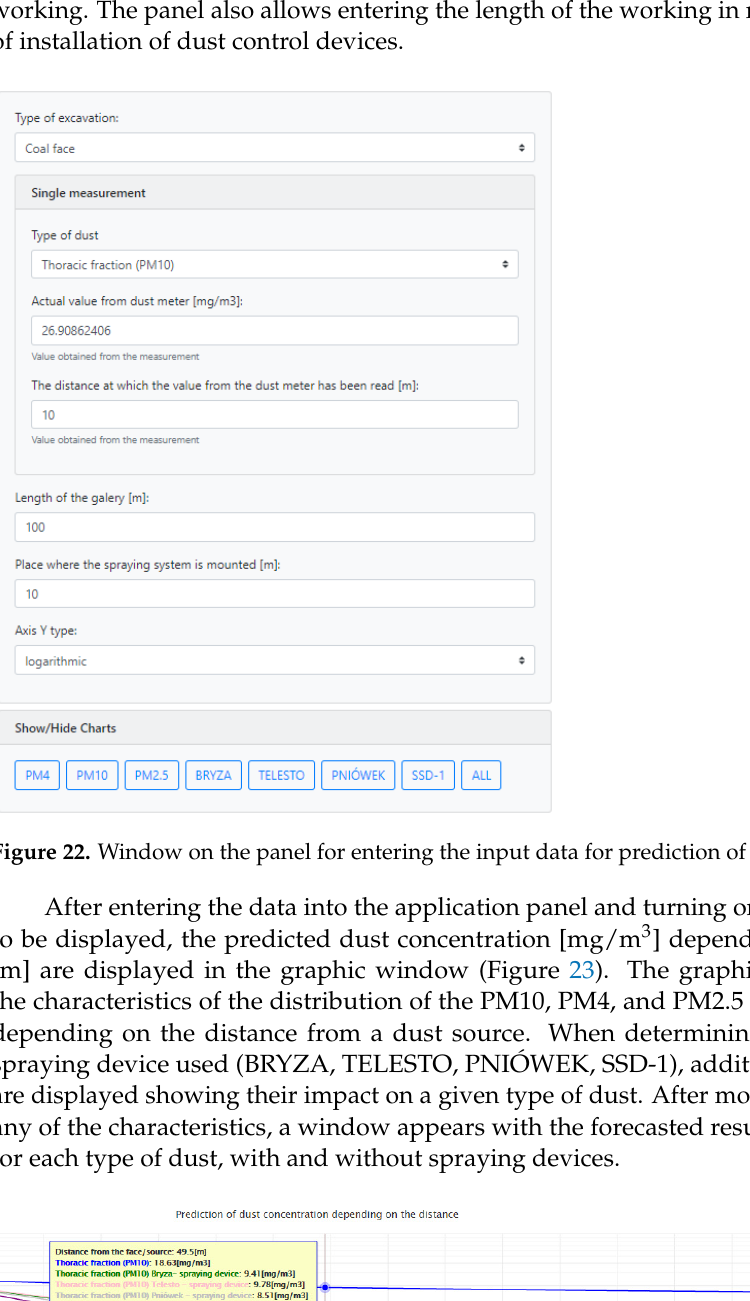
Figure 21. View of the dust prediction application, showing a graph of dust concentration depending on the distance from the dust source.